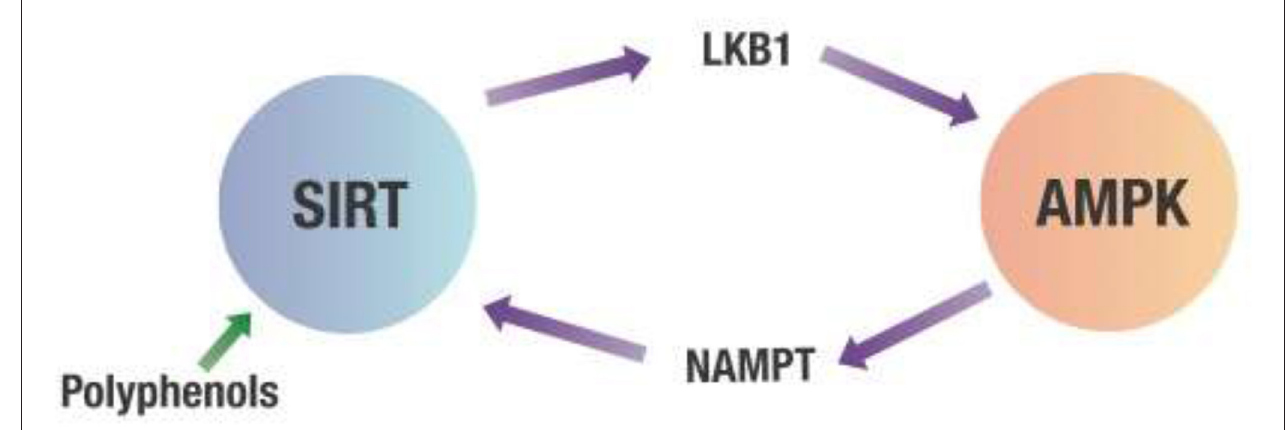
FIGURE 5 | Crosstalk between SIRT and AMPK. Any decrease in the cell’s energy state measured by an increased AMP/ATP ratio will activate AMPK. This activation of AMPK leads to increasing NAMPT activity that produces NAD + required for SIRT deacetylation activity. SIRT then deacetylates LKB1, which activates AMPK. AMPK, 5’ adenosine monophosphate-activated protein kinase; LKB1, Liver kinase B1; NAMPT, Nicotinamide phosphoribosyltransferase; SIRT, Sirtuins.